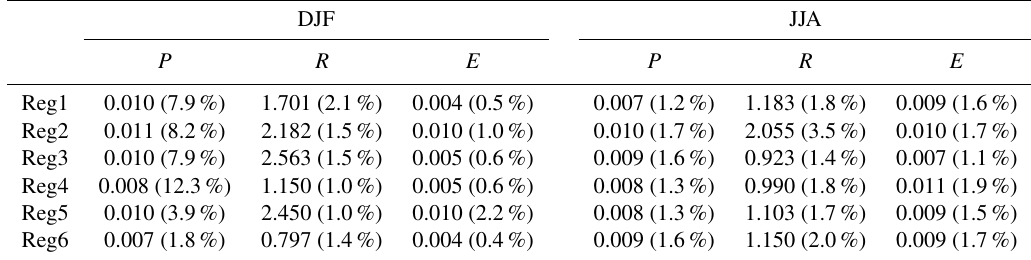
Table 2. Estimation of the error of the descriptors by using MIAAFT surrogates for winter and summer extremes. The values were calculated using the E-OBS data set for the reference period (1971–2000). In parentheses the percentage of the error with respect to the value of the E-OBS descriptors for the same time period and region are